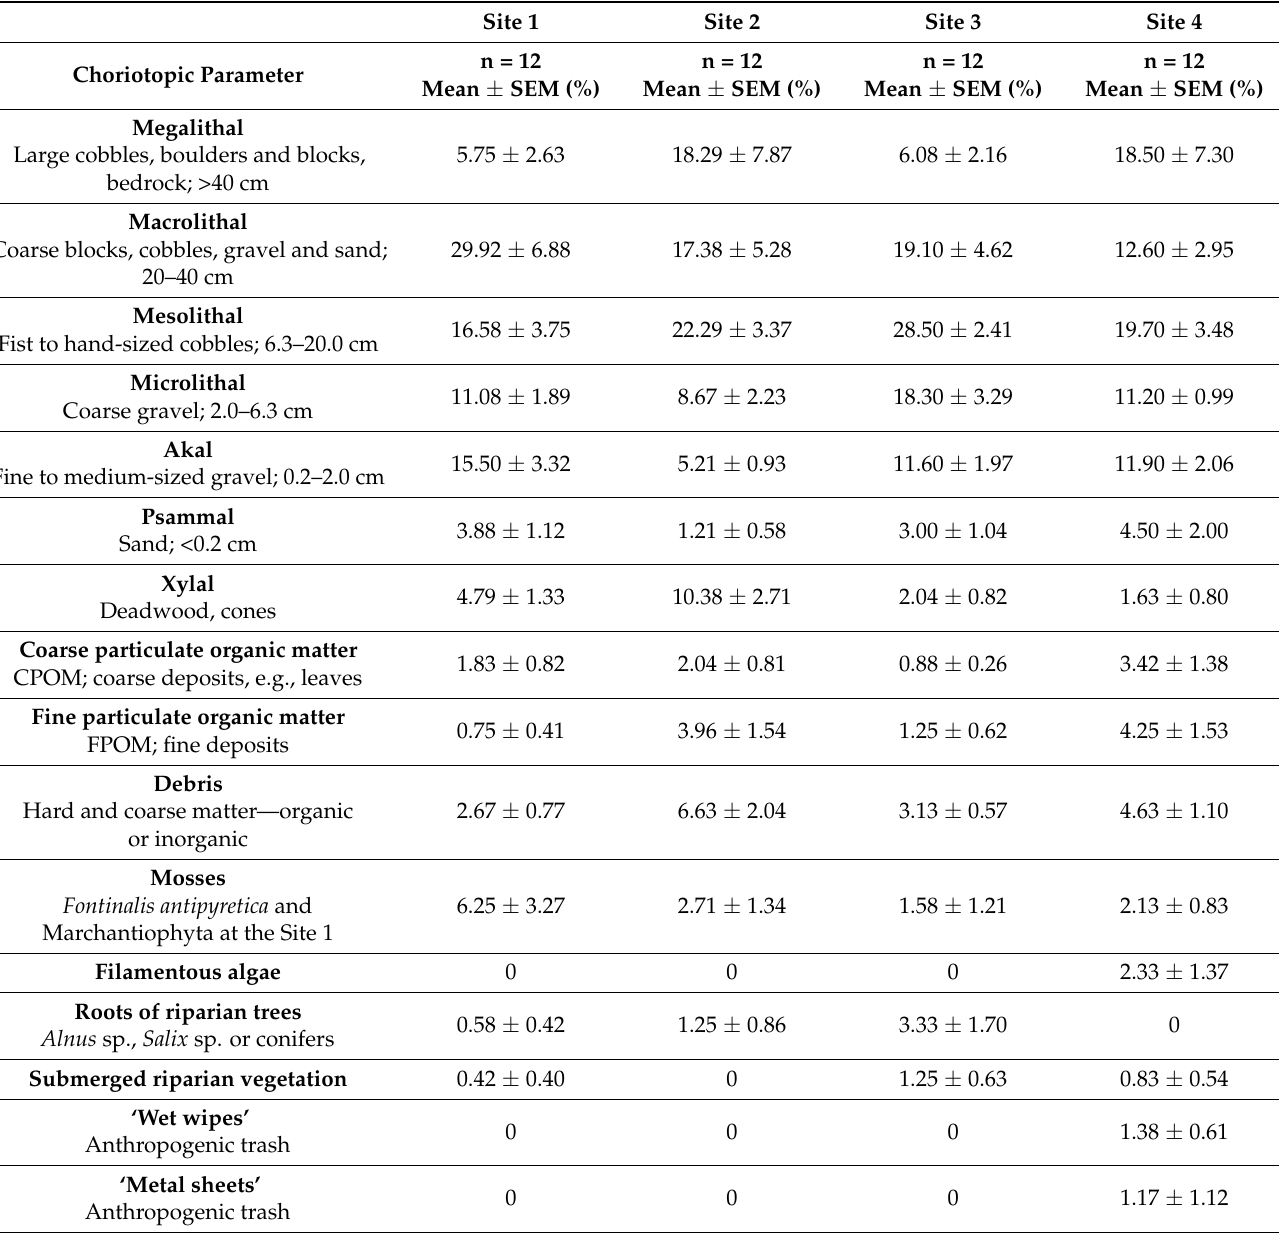
Table 4. Resulted mean choriotopic percentual compositions empirically estimated for each macro- zoobenthic sample at all given